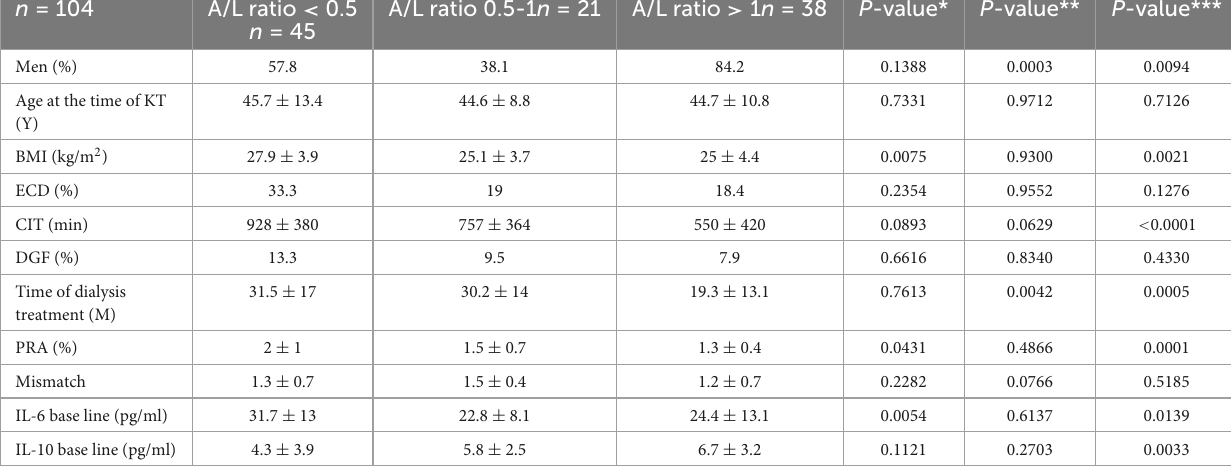
TABLE 2 Comparison of the observed groups based on A/L ratio baseline.